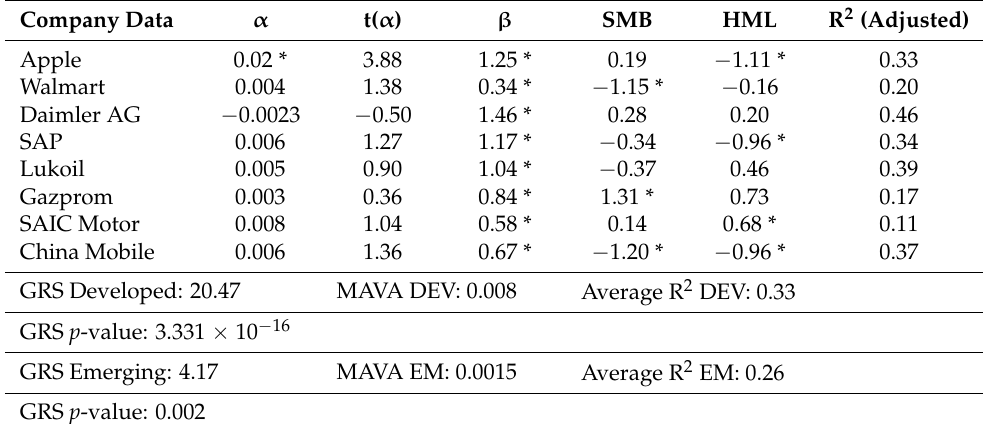
Table 6. Fama French three-factor regressions for company stock data—developed and emerging; * p <